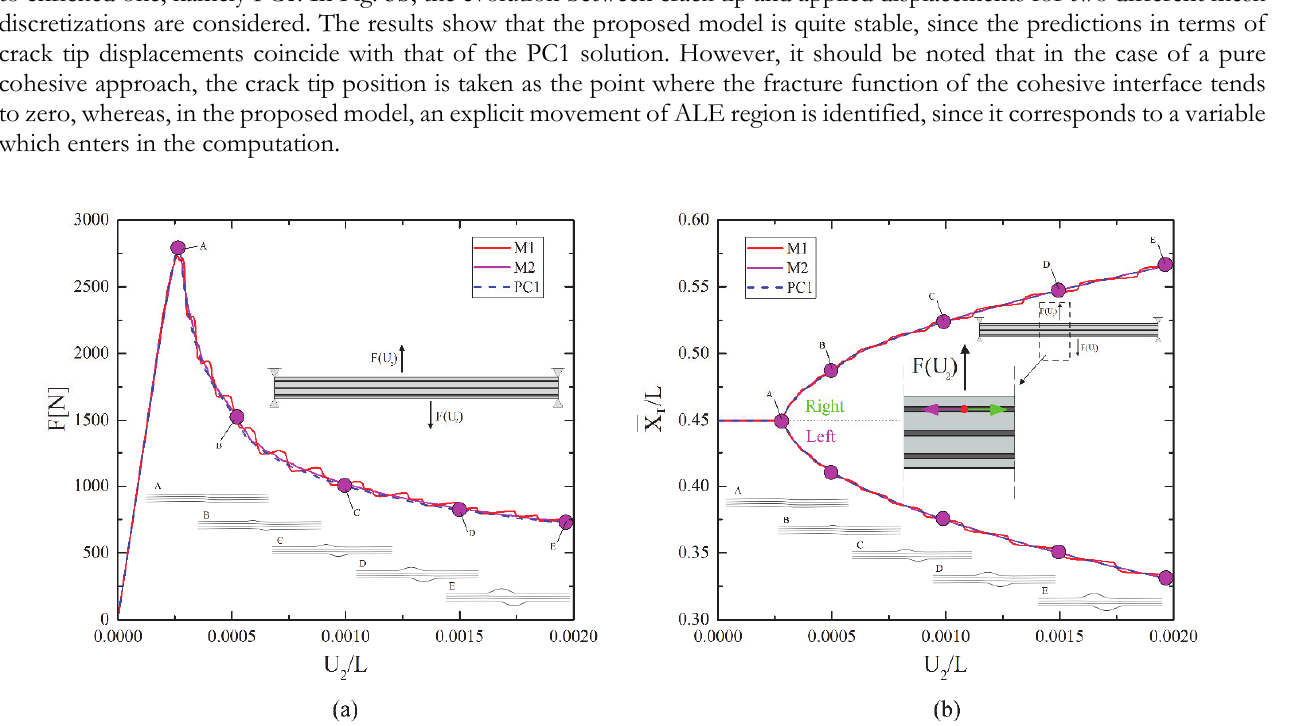
Figure 5: Comparisons in terms of loading curve with pure cohesive approach (a); Comparisons in terms of cracks tip position with pure cohesive approach (b).